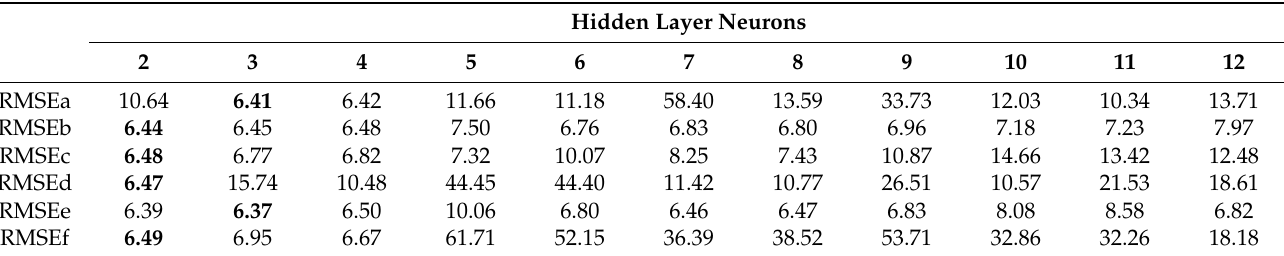
Table 5. Cross-validation training results of BPNN.